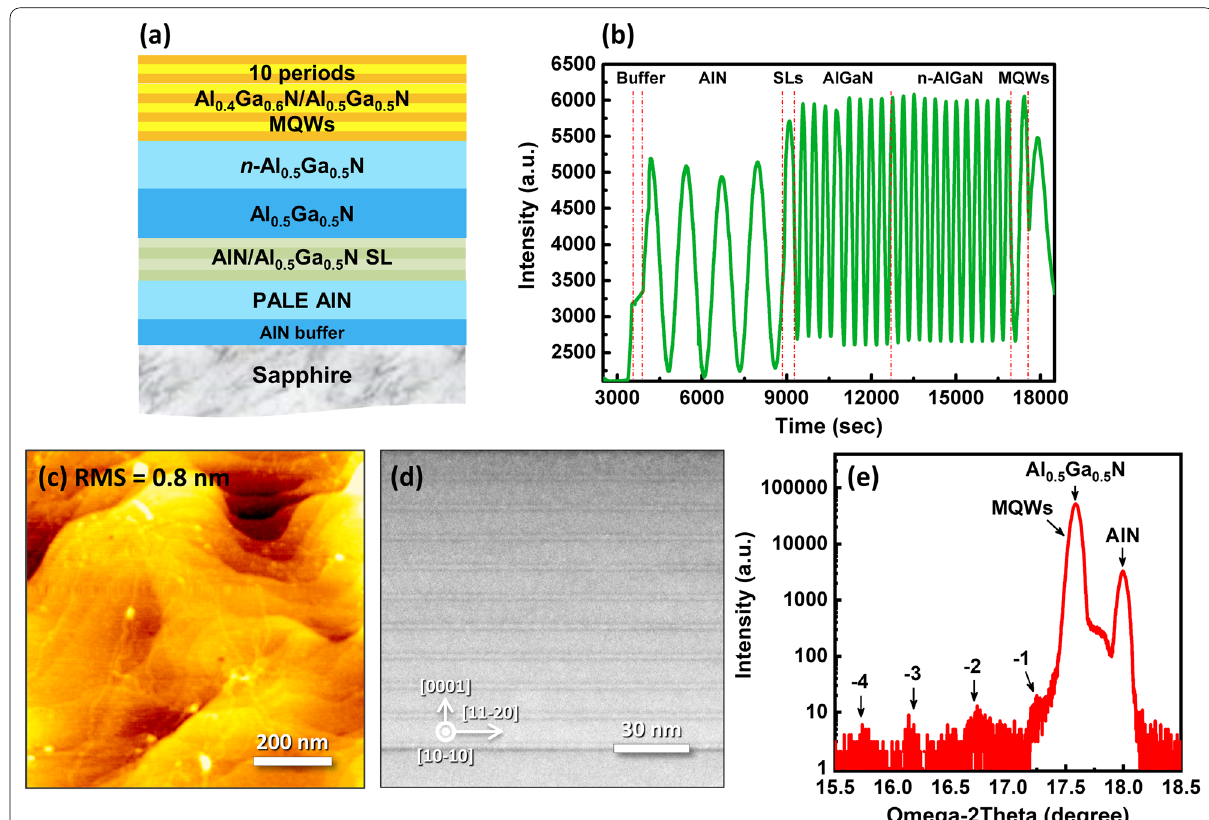
Fig. 1 a Schematic of Al 0.4 Ga 0.6 N/Al 0.5 Ga 0.5 N MQWs epitaxial structure. b Real-time monitoring curve of the complete growth process for the sample according to MOVPE. c SEM image, d AFM surface morphology, e cross-sectional TEM image, and f HRXRD (0002) ω /2 θ scan of the AlGaN